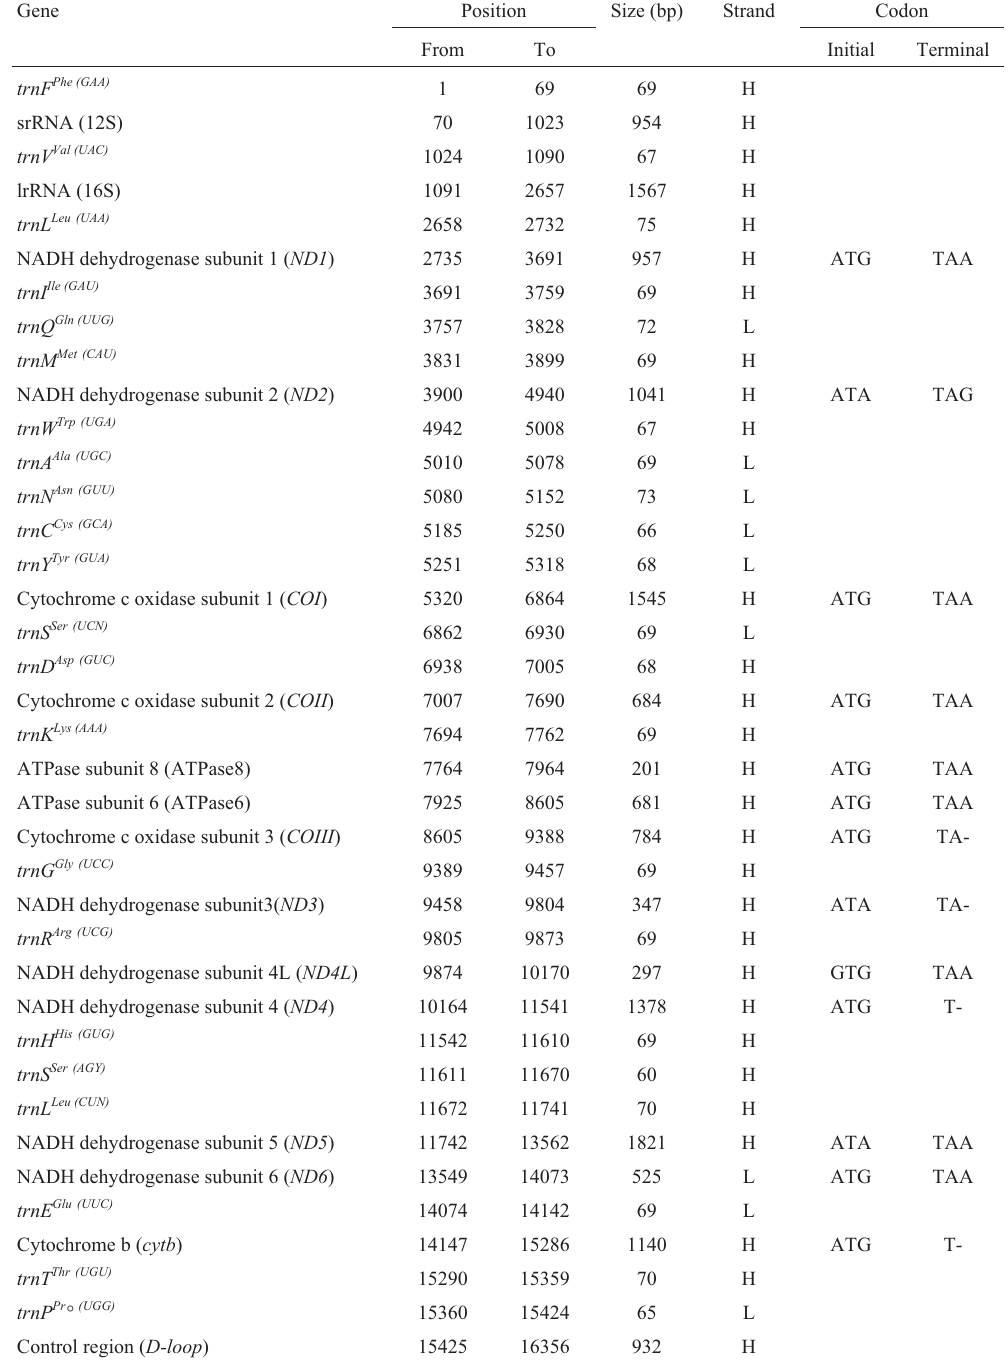
Table 2 - Characteristics of the brown brocket deer ( Mazama gouazoubira ) mitochondrial